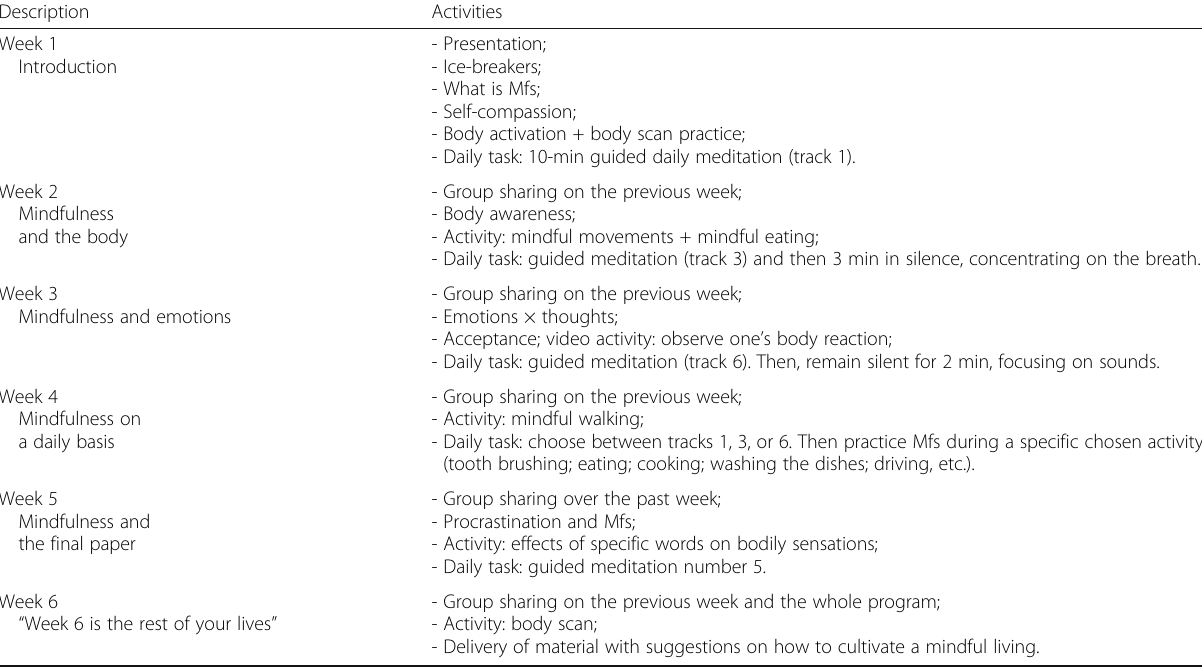
Table 3 Brief mindfulness (Mfs) program —“ TCCendo sem estresse ”